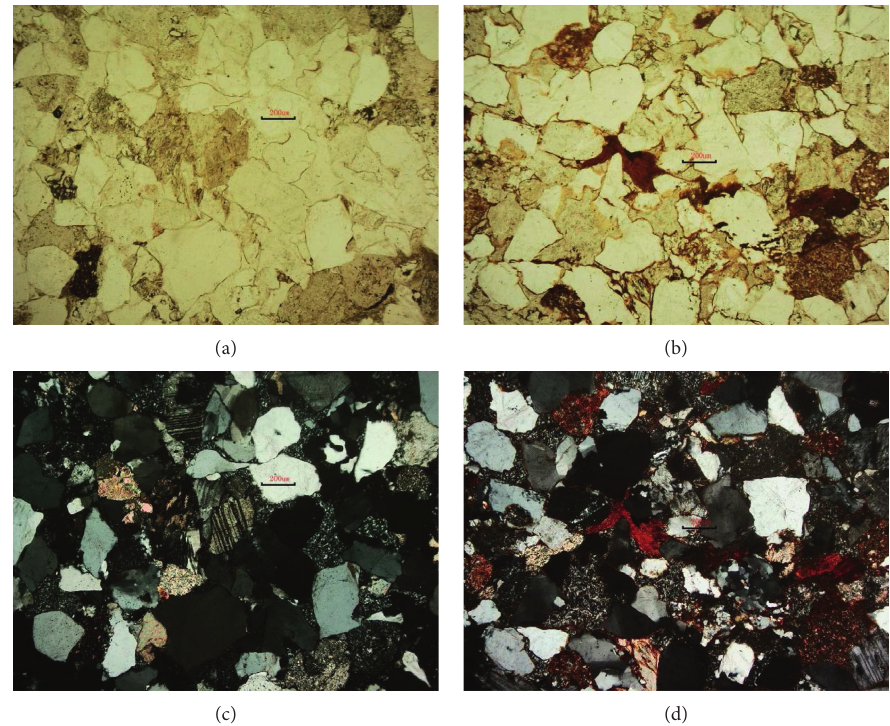
Figure 14: Photomicrographs of thin sections of sandstone: (a, b) plane-polarized light; (c, d) cross-polarized light; (a, c) room temperature; (b, d) after treatment at 600 ° C.